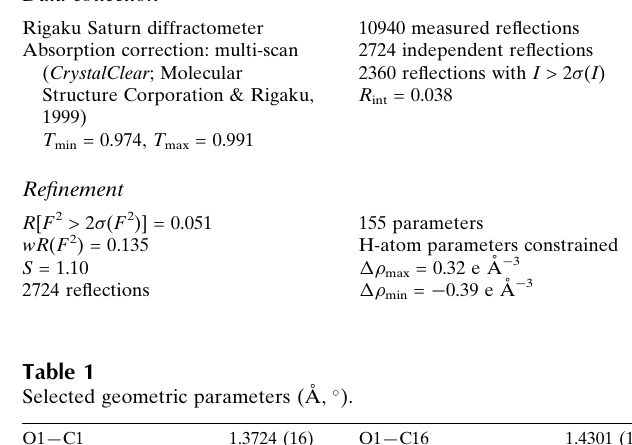
Selected geometric parameters (A˚ , (cid:1)